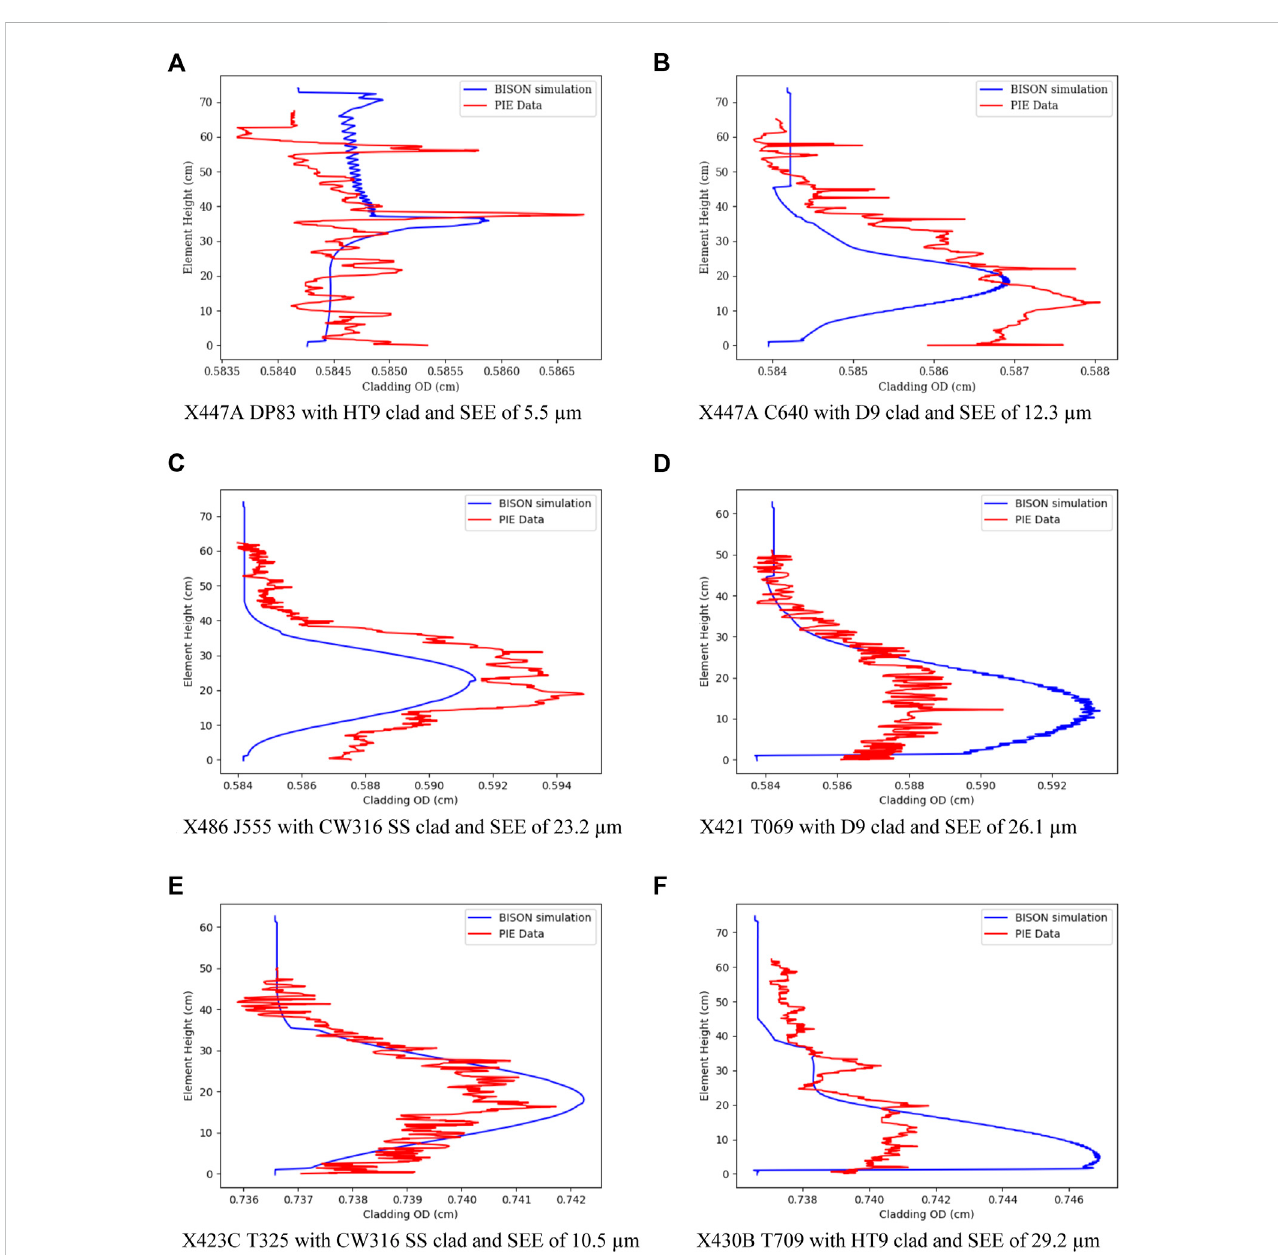
Pro fi lometry comparisons of EBR-II fuel pins with various fuel compositions and